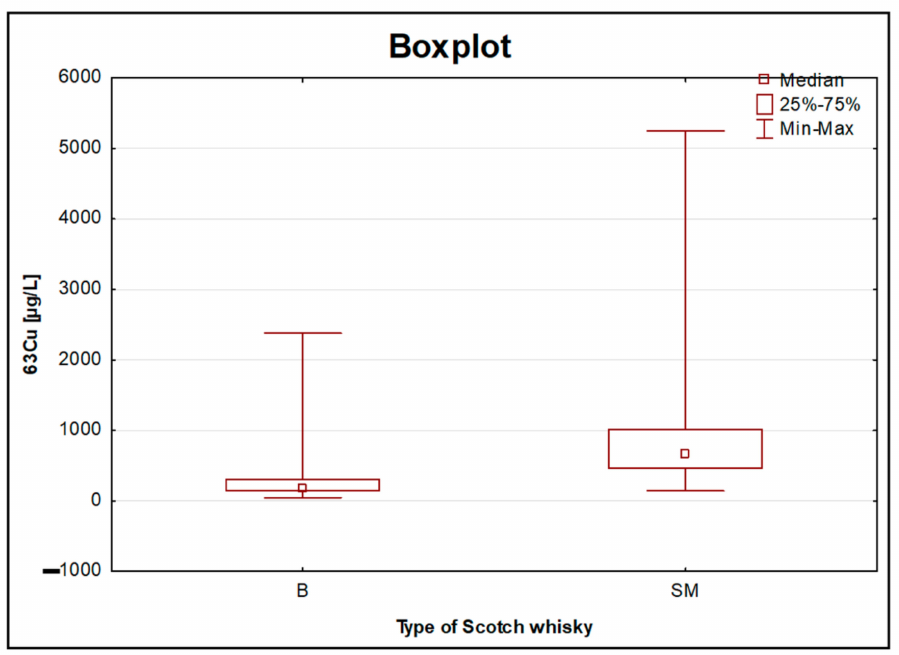
Figure 4. Boxplot for the concentration of Cu obtained for 106 objects of Scotch whisky, divided into two groups: blended (B) and single malt